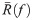
The Shannon bound for the noisy binary channel and classical code performance.The bound is shown in terms of numbers of input decisions/bits per error-free output bit. The upper single hatched region shows the R¯(f) binary symmetric case f0 = f1 = f, and the lower double hatched region shows the capacity of the fully biased Z-channel R¯(2f,0) with the same average error rate (one completely reliable input and one noisy input). Curves for the classic Hamming and Hadamard codes for various word lengths are shown for reference.